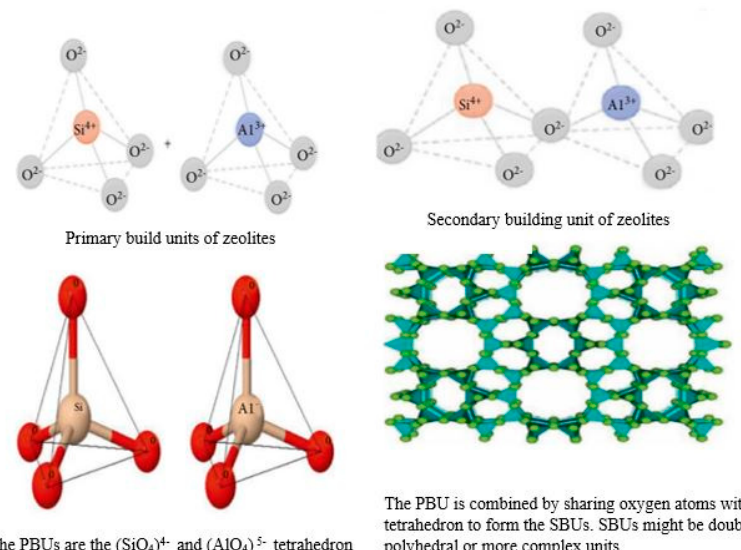
Figure 3. Structures of zeolite frameworks. Reproduced from [33]